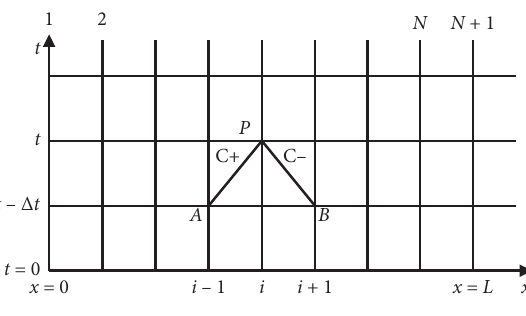
Figure 1: Schematic diagram of the feature